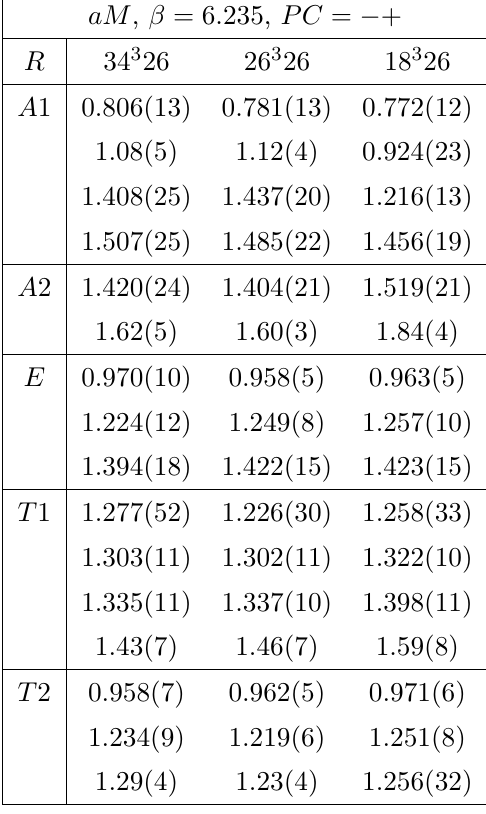
Table 4 . Finite volume check on glueball masses with P = − and C = + at β = 6 . 235 on the lattices shown. Where possible the masses are extracted from the same initial time and so are not always the same as our best mass estimates listed in other